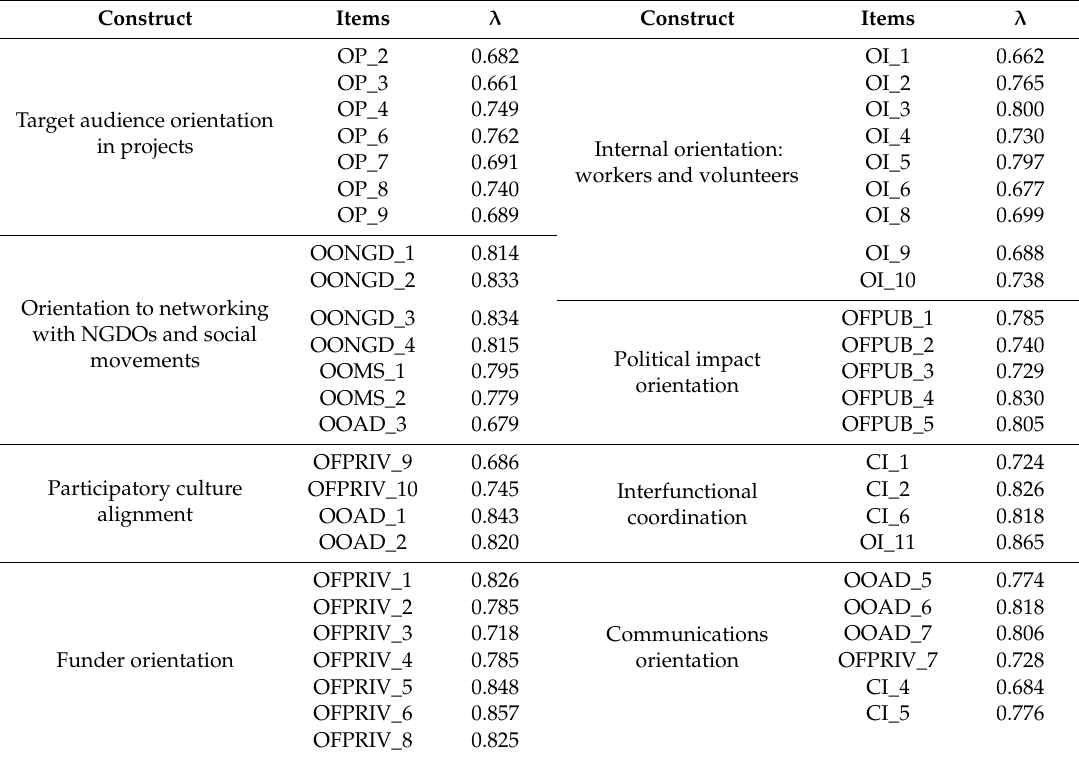
Table A3. Loadings of the items of the definitive scale.